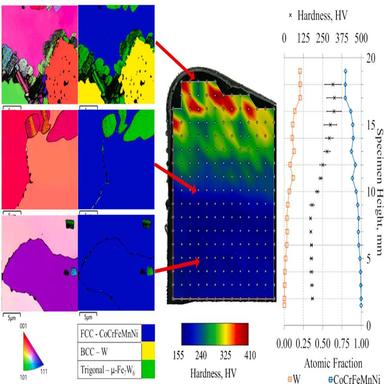
Overlays of hardness, select composition maps, average composition along build direction, phase fractions and structure information.